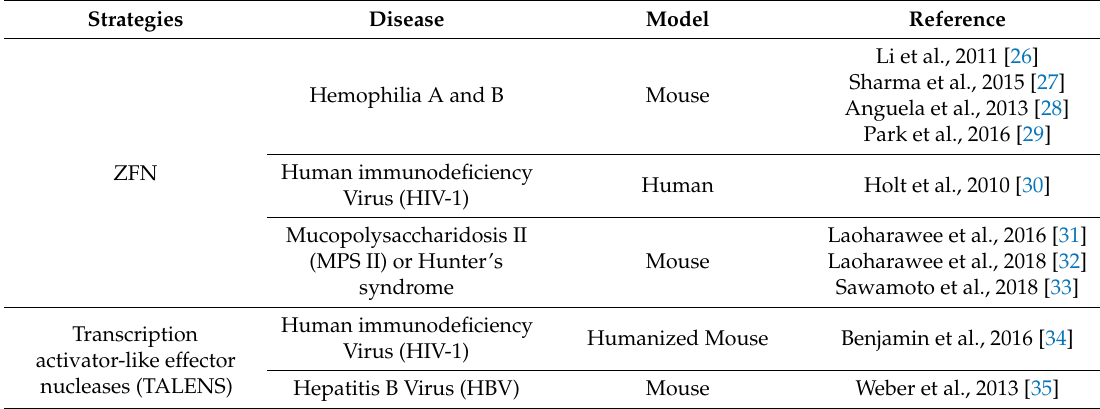
Table 1. Summary of recent advancements of in vivo pre-clinical models as a therapeutic